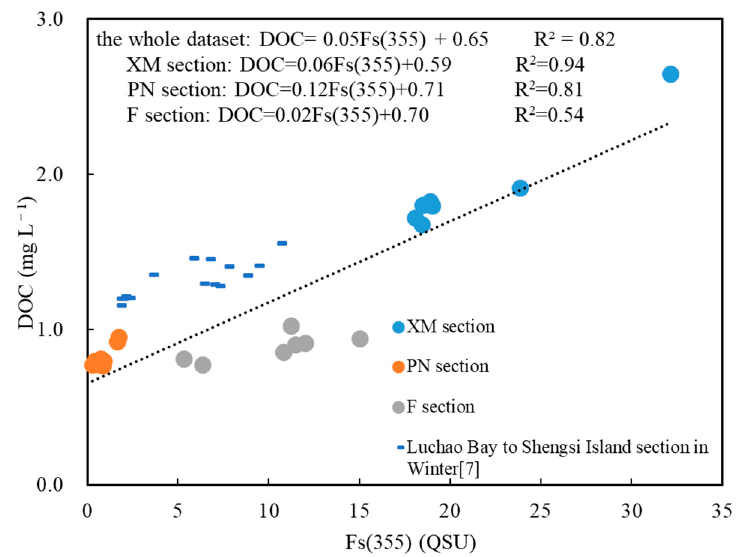
Figure 11. The correlations between the Fs(355) and dissolved organic carbon (DOC) in the three sections sampled in this study. The dataset from a previous study [7] is distributed evenly along the regression line for this study.